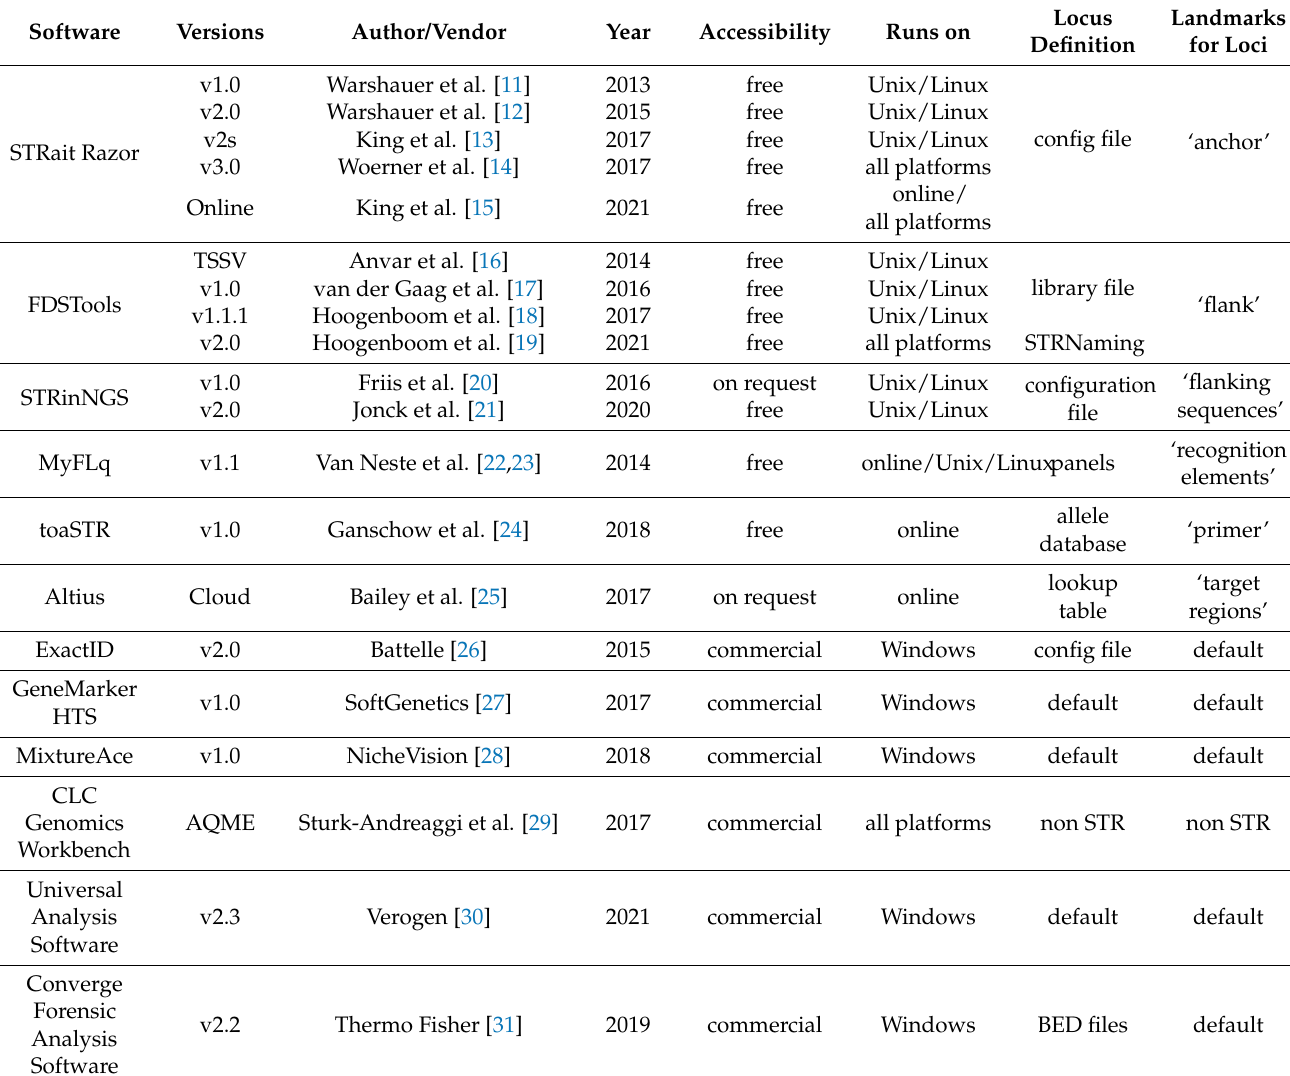
Table 1. Summary of characteristics of software for the interpretation of MPS data of forensic